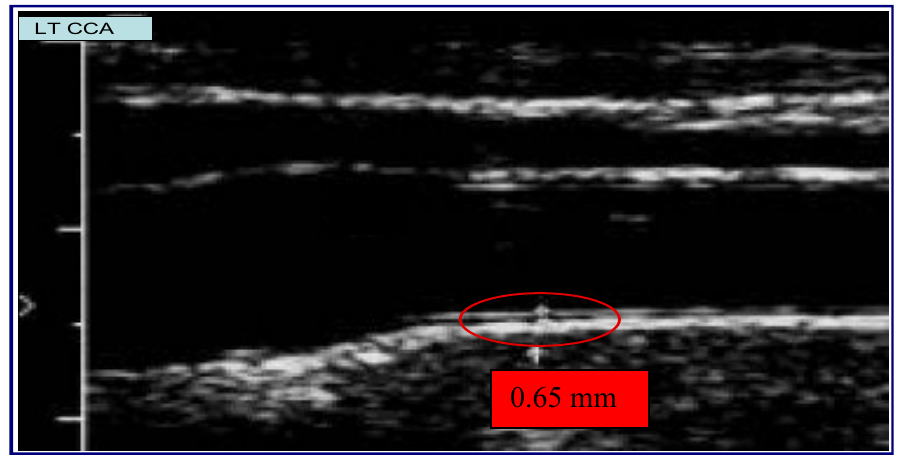
FIGURE 2. US image of the same patient as in Fig. 1. The white arrow indicates the IMT (0.65